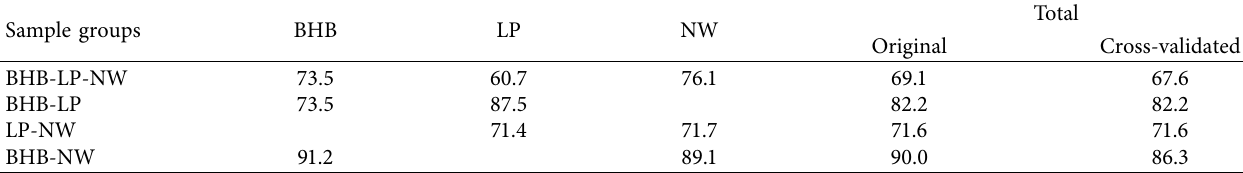
Table 5: The correct classification rate (%) of the training set obtained by SLDA.